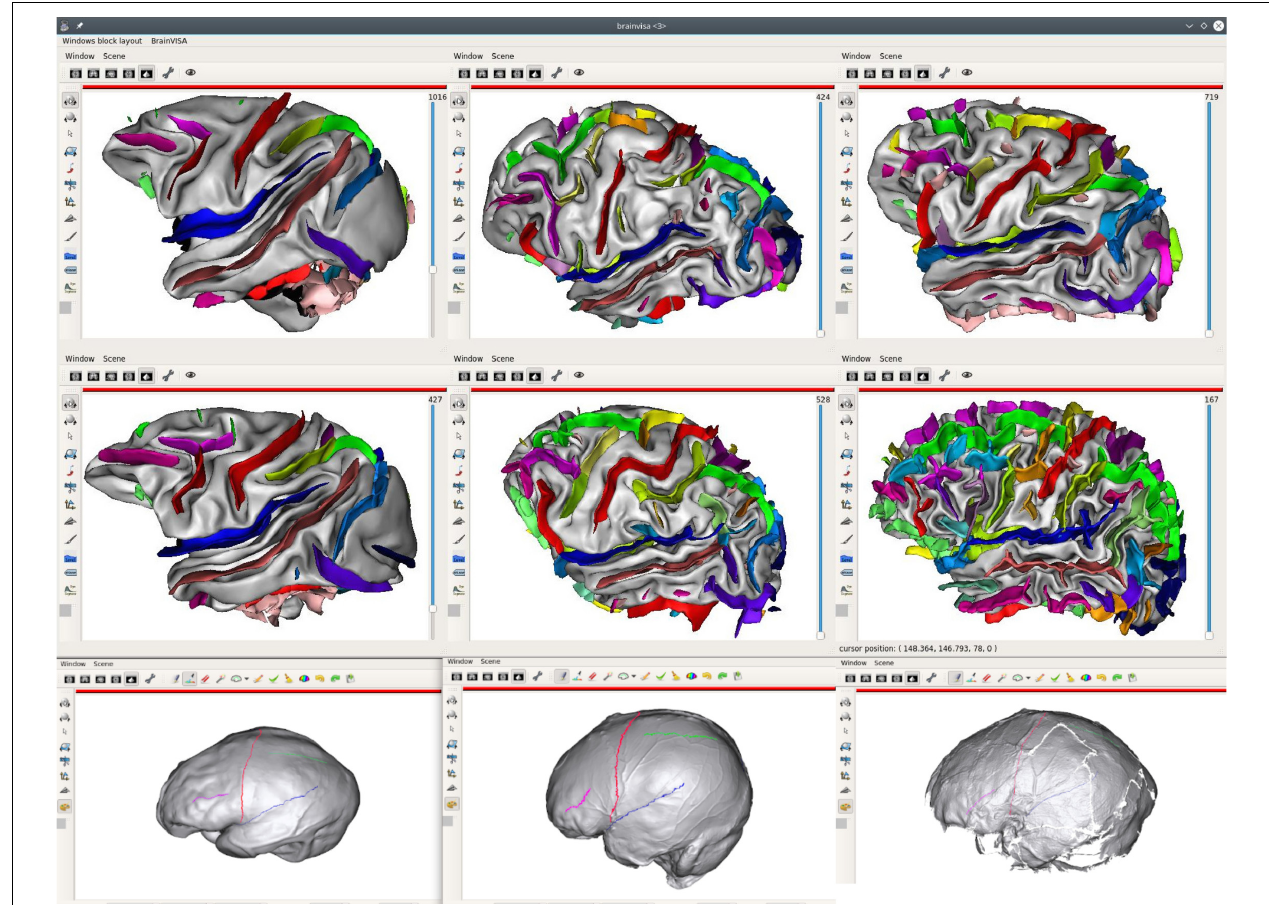
FIGURE 8 | Inter-species sulci comparison structural atlas; the first two lines of the figure display sulci of 6 different species (from left to right, and then, top to bottom: a macaque, a pongo, a chimpanzee, a baboon, a gorilla, a human). Sulci have been manually identified on these brains, using a common sulci nomenclature, in order to get structural correspondence between subjects/species. The last line extends the comparative study to extinct species using skull endocasts, using another Anatomist feature, allowing to draw sulcal lines (Le Troter et al., 2012) [from left to right: Sinanthrope XII (an Homo erectus), a recent Homo sapiens, La Ferrassie 1 (an Homo neanderthalensis] (Balzeau and Mangin,